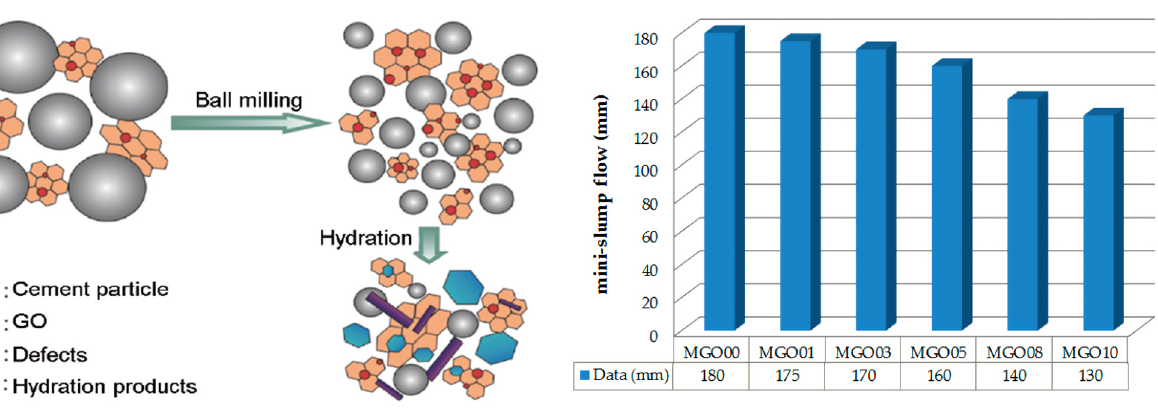
Figure 6: Schematic illustration of reinforced cement paste [ 55 ] .